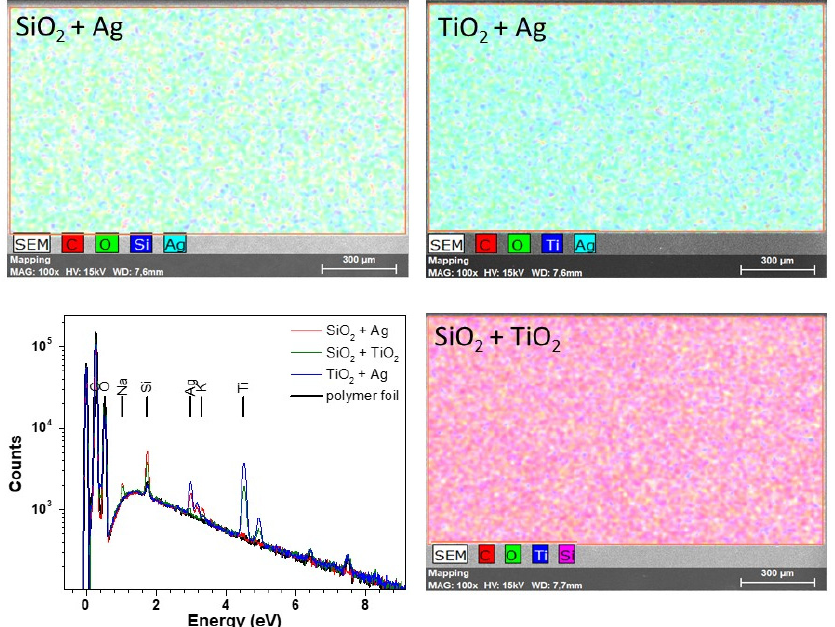
Figure 9. EDX spectra and element distribution of the polymer foils and the foils deposited with TiO 2 + Ag films, SiO 2 + TiO 2 , SiO 2 + Ag; all films have a total thickness of ~33 nm.